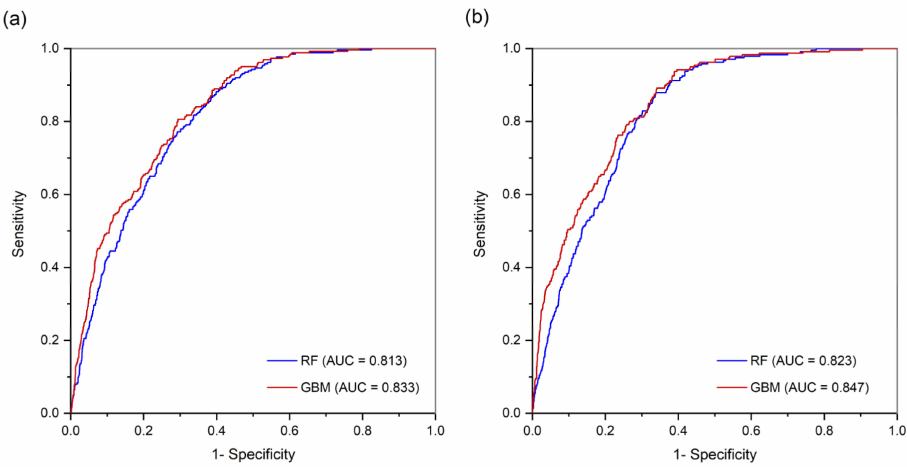
Figure 4. ROC analysis with GBM and RF models for validation ( a ) and test ( b )